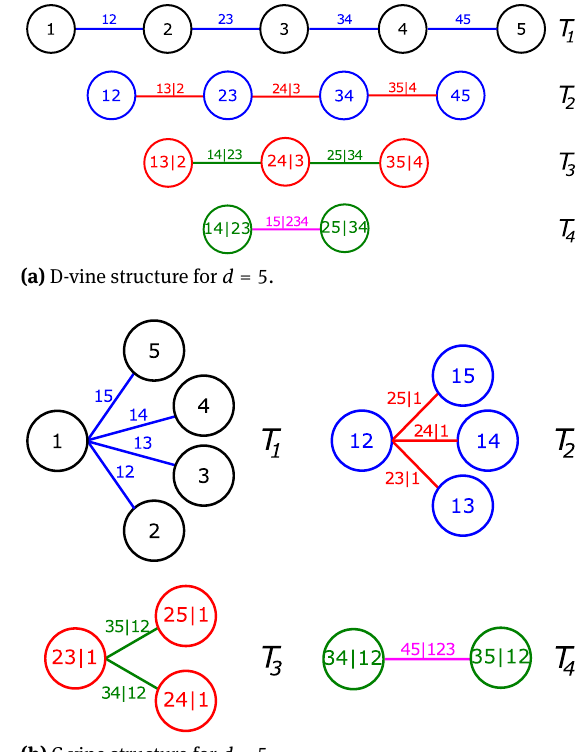
Figure 9: D-vine and C-vine structures for d = 5